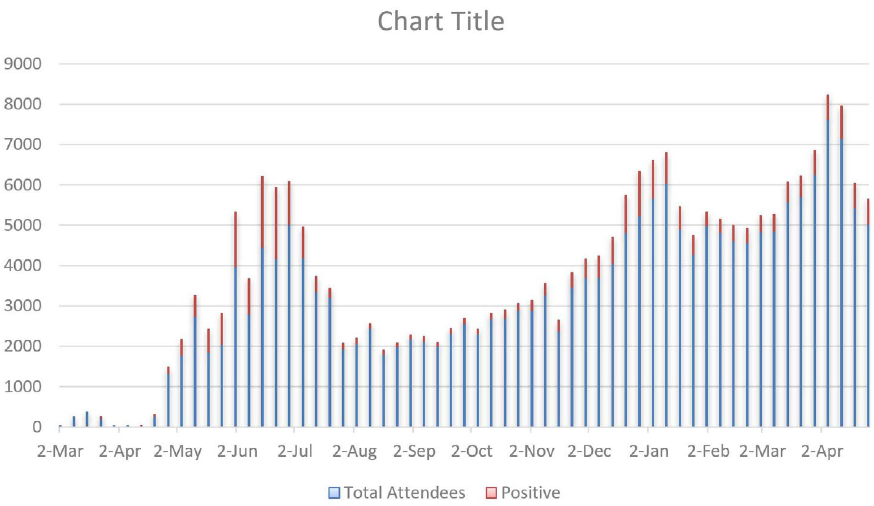
Fig. 2. The weekly changes in the number of attendees and the number of positive COVID-19 PCR cases in the Reference Laboratory of the Egyptian Universities’ Hospitals over a period of 61 weeks